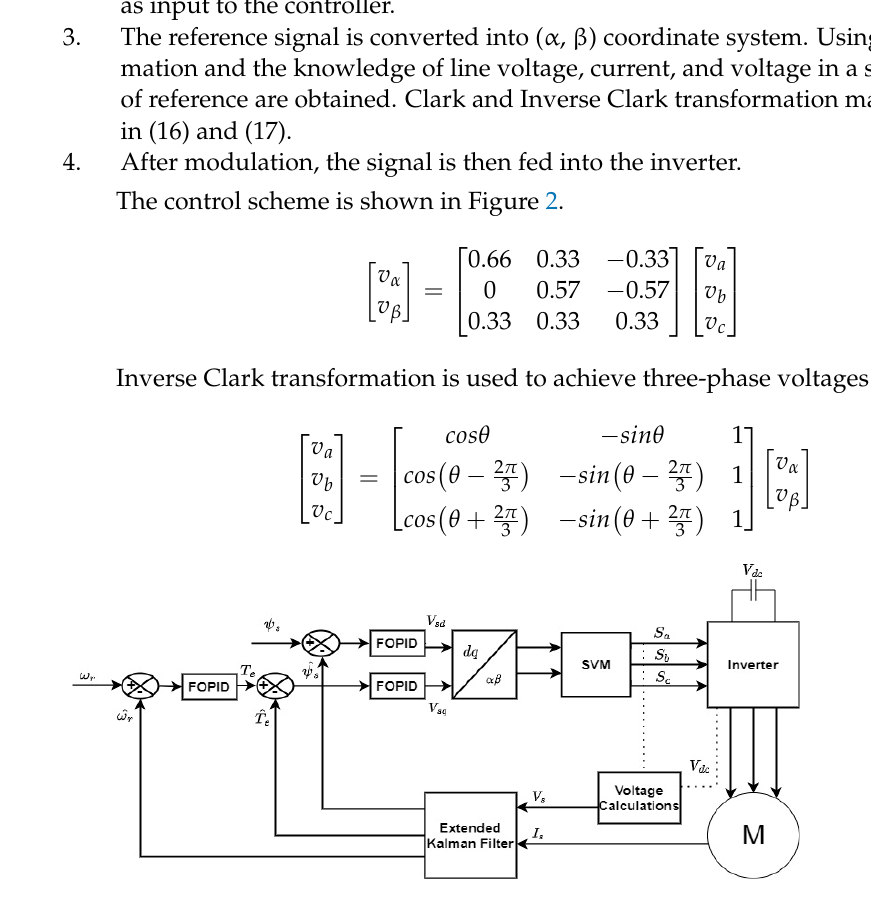
Figure 2. Proposed control Strategy using extended Kalman filter. Fractional − Order Controller